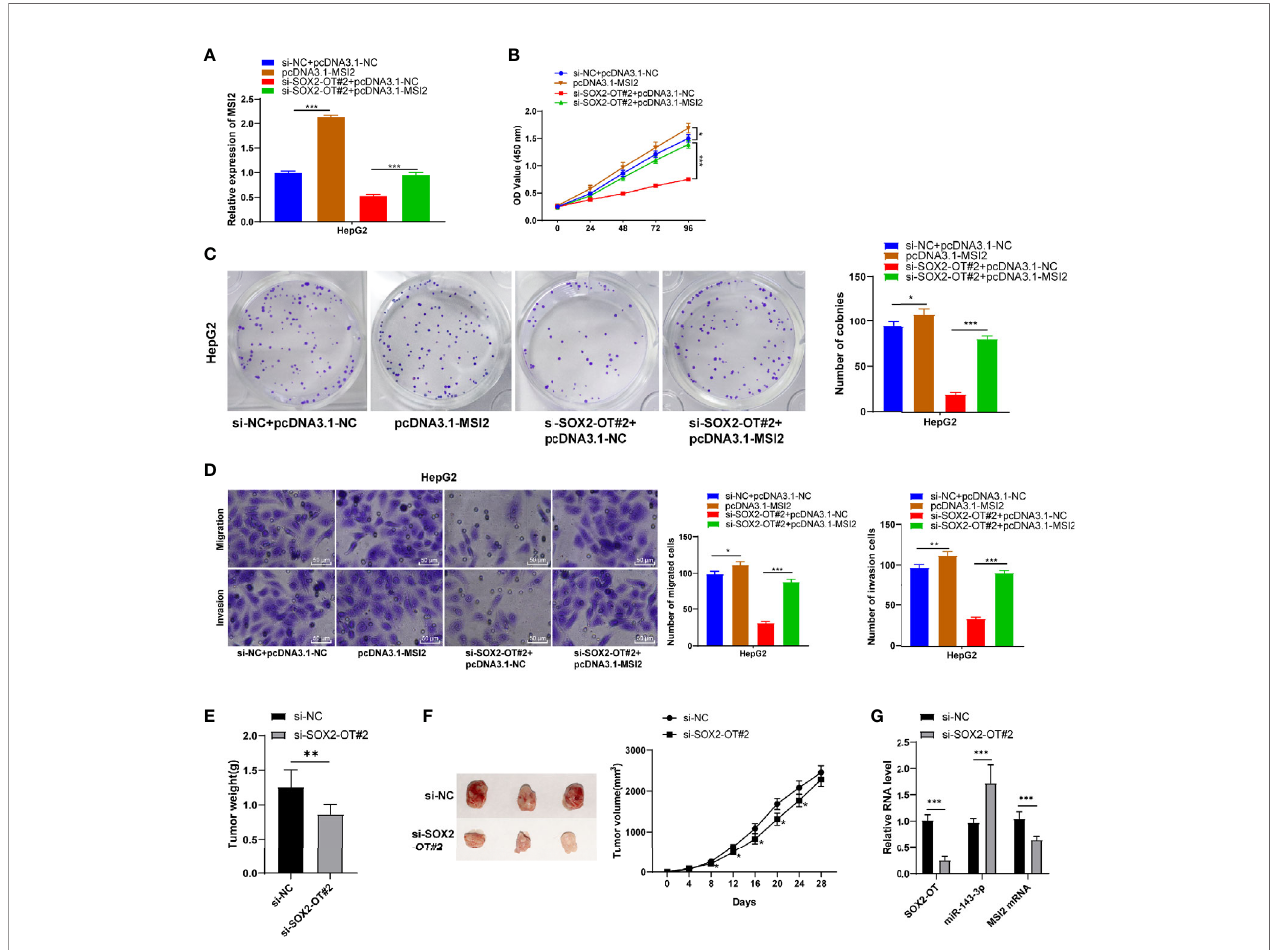
FIGURE 5 | Upregulation of MSI2 could reverse the role of si-SOX2-OT in HCC. pcDNA3.1-MSI2 was delivered into HepG2 cells which were transfected with si-SOX2-OT#2, and the cells with si-NC + pcDNA3.1-NC were used as control. Then, (A) RT-qPCR was used to verify the intervention effect of pcDNA3.1-MSI2; (B) CCK-8, (C) colony formation assay, and (D) Transwell assays were utilized to assess proliferation, invasion, and migration of the cell; (E) After 4 weeks of subcutaneous tumorigenesis in nude mice, tumor bodies were obtained and tumor weight was measured; (F) Changes of tumor volume within 4 weeks after subcutaneous tumorigenesis in nude mice and typical pictures; (G) The levels of SOX2-OT, miR-143-3p and MSI2 protein in tumor bodies were detected by RT- qPCR. There were 6 mice in each group. The cell experiment was repeated three times independently and data were all metrological data. All data were shown as mean ± standard deviation. One-way ANOVA was used for data analysis, followed by Tukey ’ s test. * P < 0.05, ** P < 0.01, *** P <